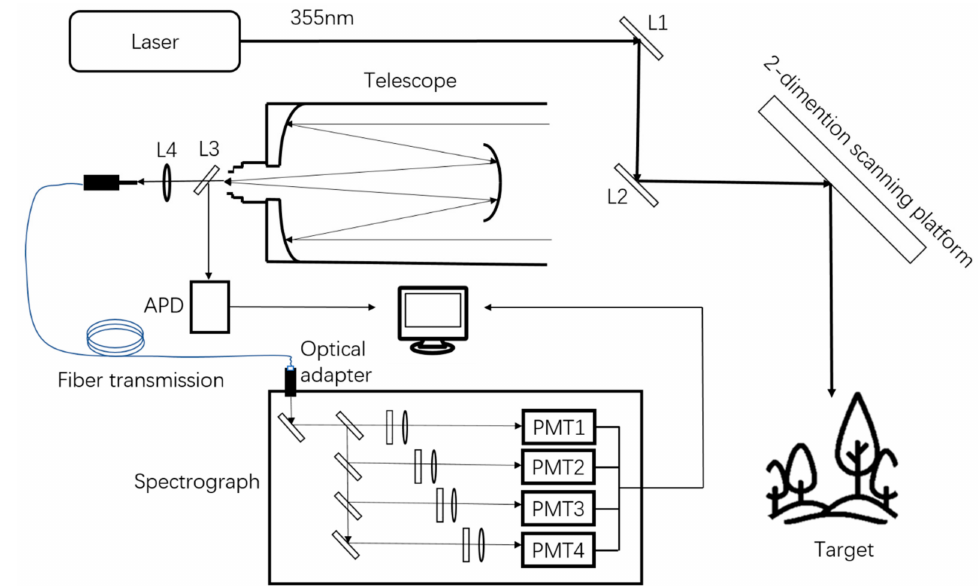
Figure 2. Block diagram of the multi-wavelength fluorescence